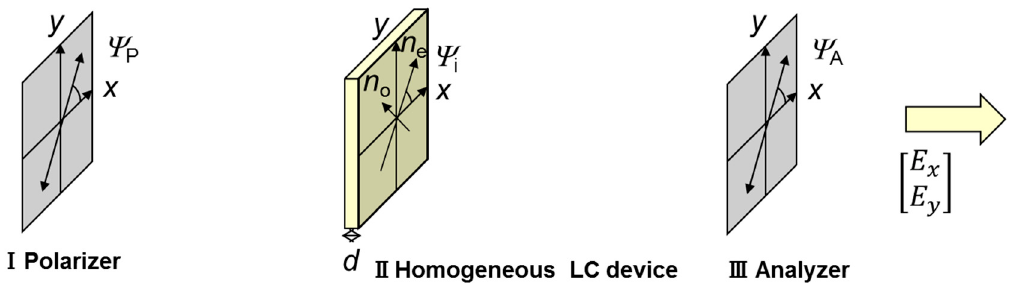
Figure 4. The Jones matrix calculation for the homogeneous alignment of the LC device in the terahertz region.